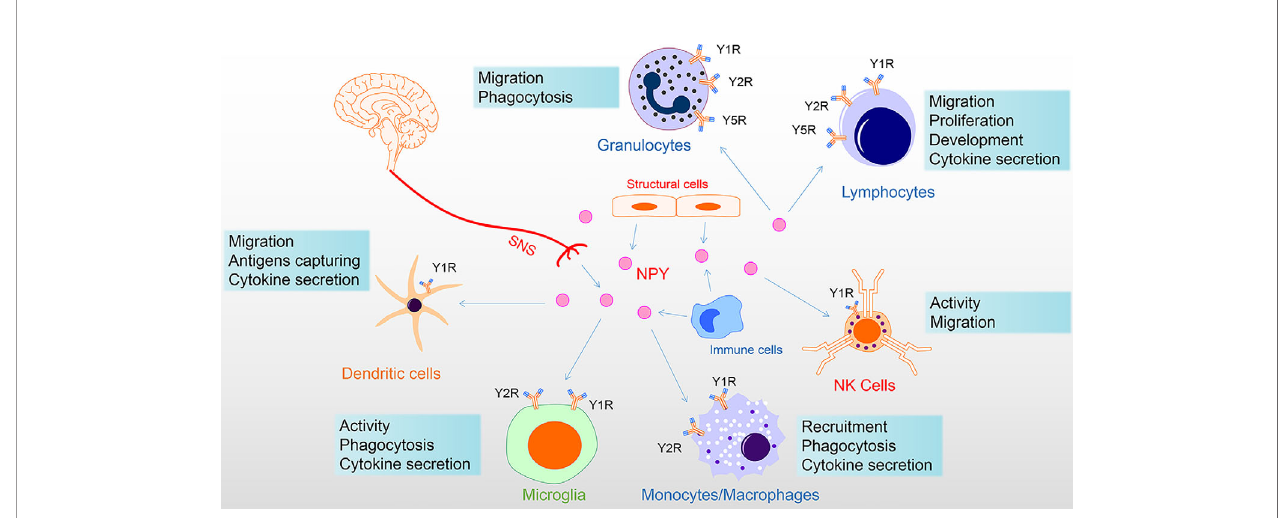
FIGURE 2 | NPY directly regulates immune cells. NPY of the immune system derived from the secretion of the sympathetic nervous system, tissue structure cells, and immune cells. NPY plays multiple roles in immune cells, including via Y1R inhibiting activation and regulation of proliferation, differentiation, and cytokine secretion; via Y1R/Y2R/Y5R mediating phagocytosis and migration. Among these, Y1R has a bimodal effect on the immune system, showing both anti-in fl ammatory properties and speci fi c pro-in fl ammatory effects. In addition, the Y1R mainly mediates the promotion of NPY, while the Y2/Y5 receptor mediates the inhibition of NPY. Therefore, the interaction of Y1R and Y2/Y5R is involved in the regulation of immune cells. In this fi gure, NPY receptor symbols on different immune cells symbolize their involvement in the diverse functional regulation of NPY. NK, natural killer; NPY, neuropeptide Y; SNS, sympathetic nervous